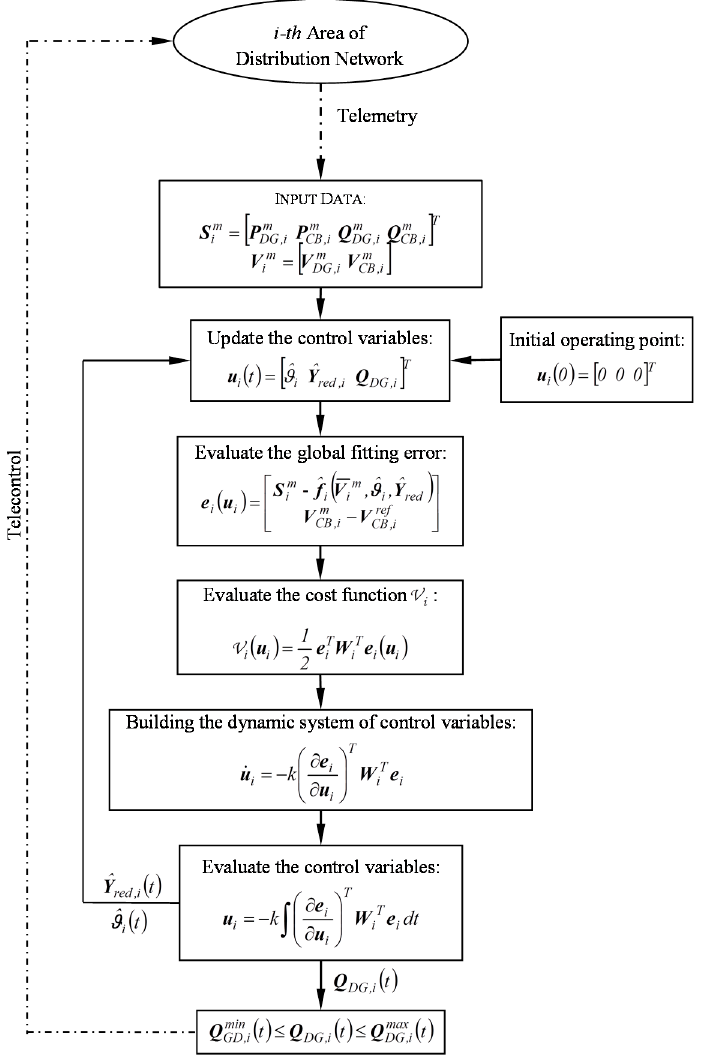
Figure 2. Flow-chart of the proposed optimization algorithm.